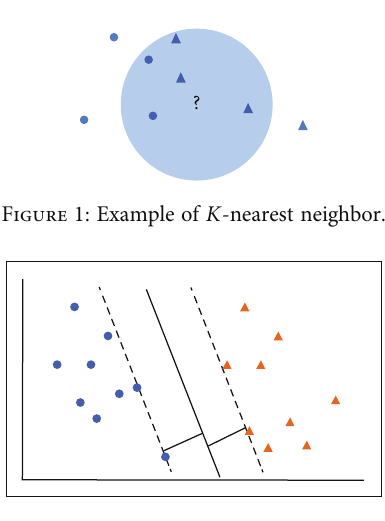
Figure 2: Optimal “ hyperplane ” in two-dimensional feature